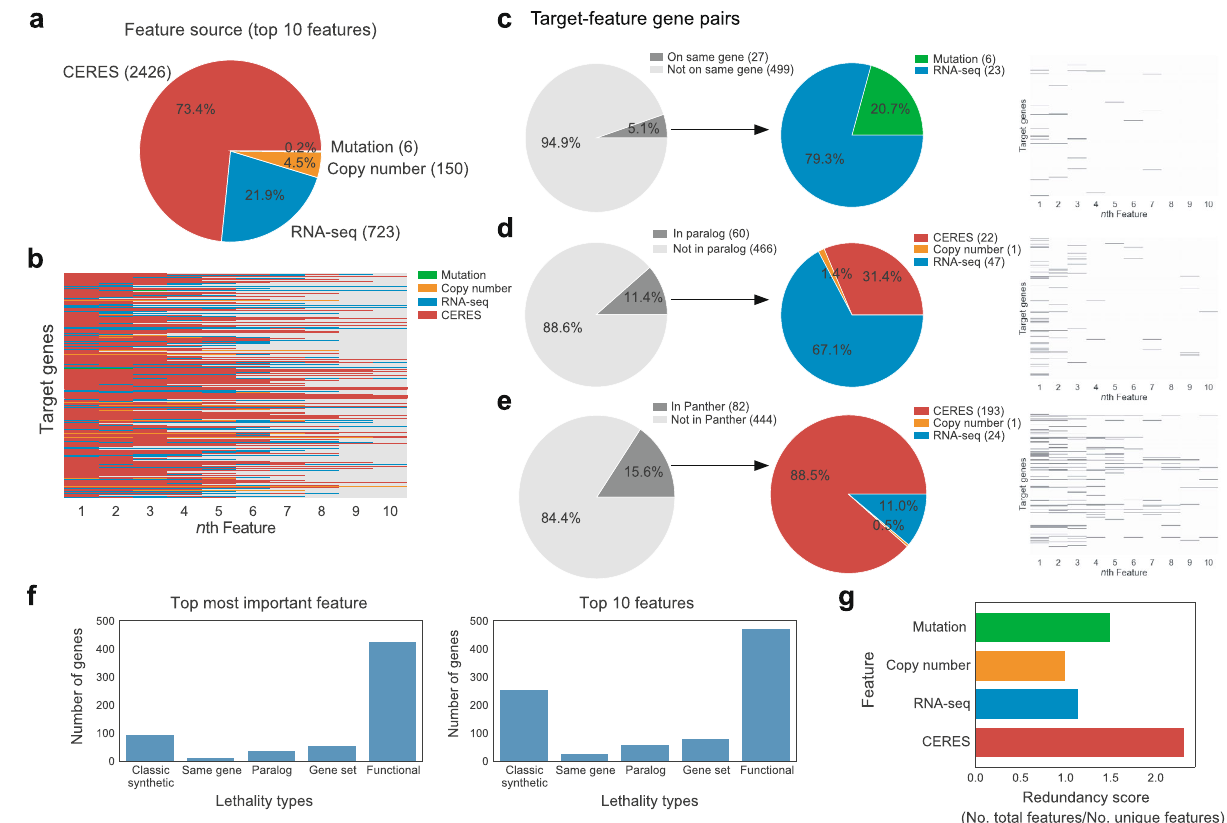
Fig. 2 CRISPR CERES scores are the most prominent predictive features in multivariate models. a The distribution of the top ten features per data source from the multivariate models in Fig. 1 are aggregated across all models. CERES scores are highly enriched as features in these multivariate models. b A heatmap view of all target genes for n th feature, colored by the data source. Gray indicates there were less than ten predictive features for the target gene. c – e The relationship between the top ten features for every cell-type-speci fi c gene and whether they are from the same gene ( c ), paralogs ( d ), or in network gene set Panther ( e ), as visualized in the gray pie charts and heatmaps. Of the feature-target gene pairs within each group (dark gray), they are further broken by data source (colored pie charts). f Examining the top feature in every model, we classi fi ed which model of cell-type speci fi city that feature belonged to. g Redundancy scores are measured as the ratio of the total number of features to the total number of unique features, measured per data source (CERES, RNA-seq, mutation, copy number, lineage). Source data are provided as a Source Data fi